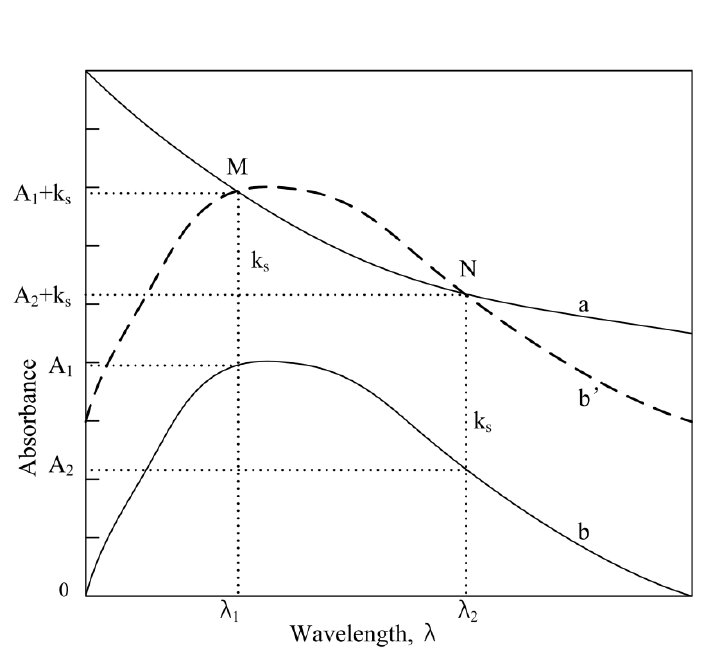
Figure 1. Absorption spectra sketch: a, suspension particle liquid against water; b, absorption spectrum of a color solution; b’, the same as curve b but the absorbance was shifted up by k s distance; λ 1 , peak absorption (M point) at primary wavelength; λ 2 , valley absorption (N point) at secondary wavelength.